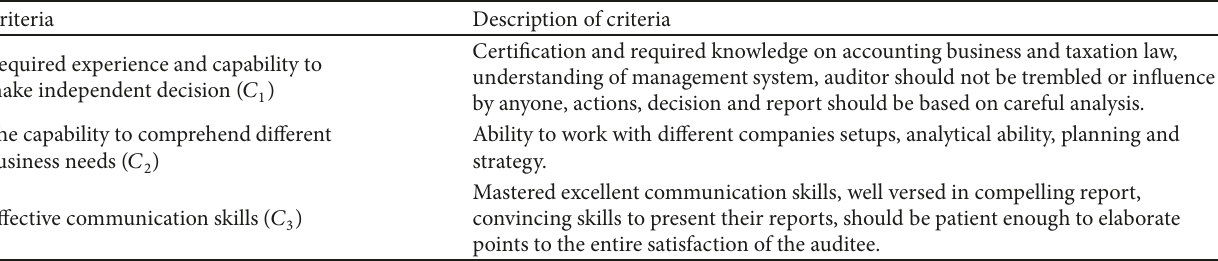
Table 5: Criteria to evaluate an audit company.